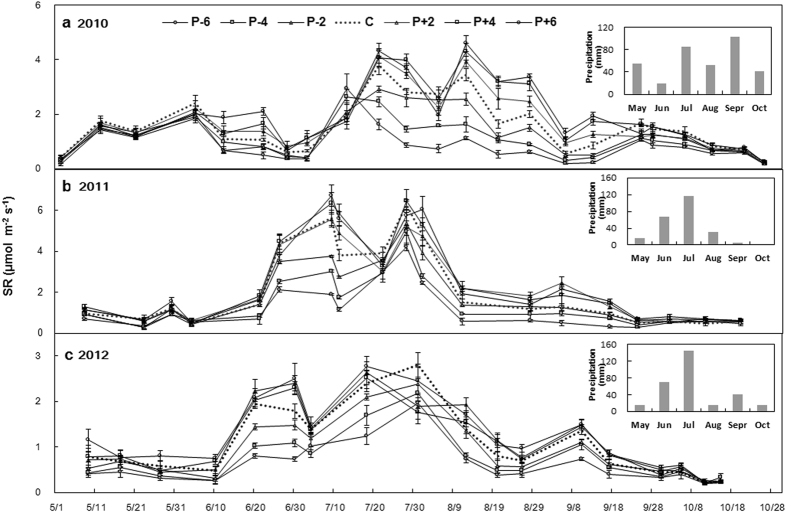
Dynamic variations of soil respiration (SR) in the three growing seasons, respectively.The inserted subplots are annual mean values (means ± 1SE). See Fig. 1 for abbreviations.